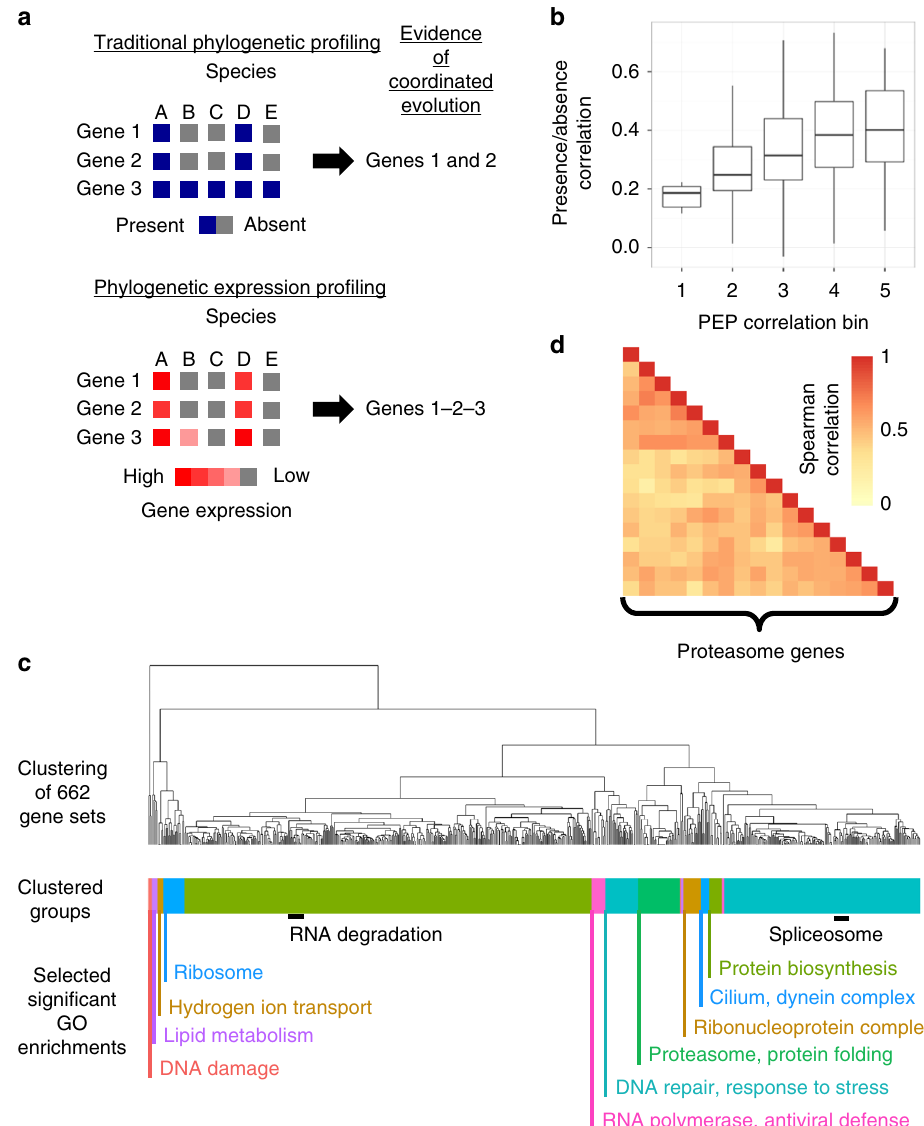
Fig. 2 Phylogenetic expression pro fi ling reveals coordinated evolution within gene sets. a Overview of traditional phylogenetic pro fi ling (PP; top) and phylogenetic expression pro fi ling (PEP; bottom). PEP uses the quantitative gene expression levels across species rather than the binary presence/absence of a gene. Patterns of coordinated evolution hidden to PP can be potentially uncovered using PEP. b For ciliary genes, pairwise PP correlations increase with PEP correlation strength. c The 662 gene sets with signi fi cant PEP scores are clustered by the pairwise correlations between gene sets. The color bar below the dendrogram shows the 15 unique gene set groups the dendrogram was divided into and gene ontology enrichments for each group are highlighted in the same color. Black bars highlight notable groups of gene sets within the larger groups. d Proteasome genes were found to be undergoing coordinated evolution and are shown as a